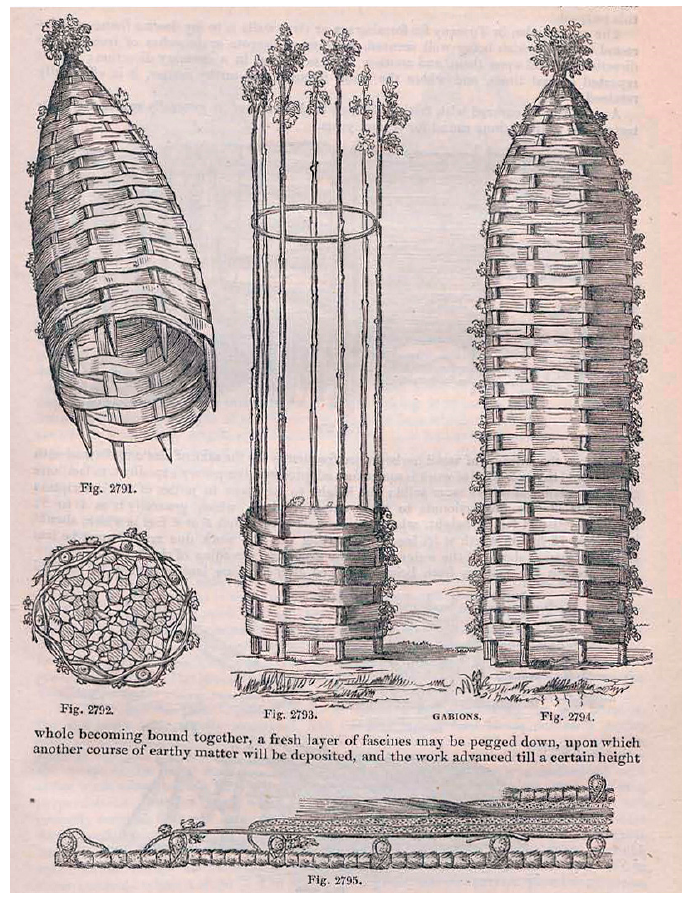
Figure 1. Gabions construction scheme by Cresy [15].